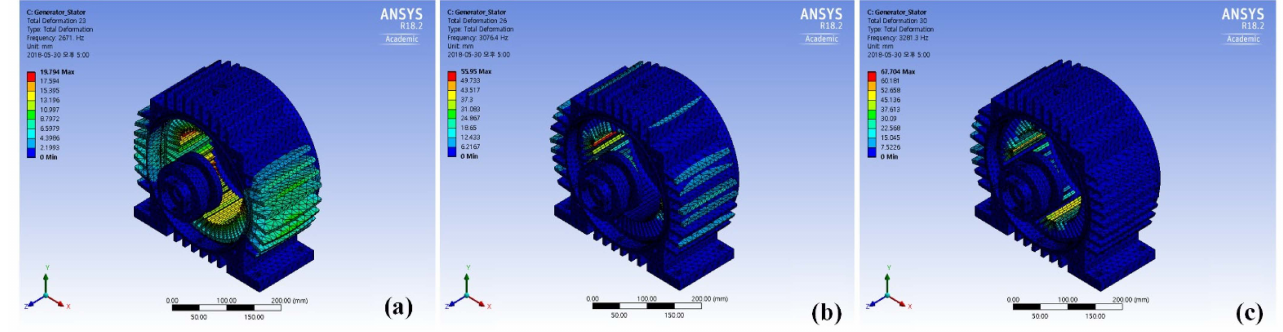
Figure 12. Modal analysis for the stator with the housing: ( a ) first, ( b ) second, and ( c ) third modes.